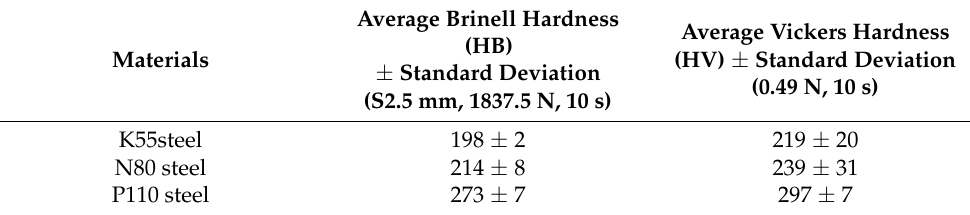
Table 2. Hardness measurement for the different microstructure steels.